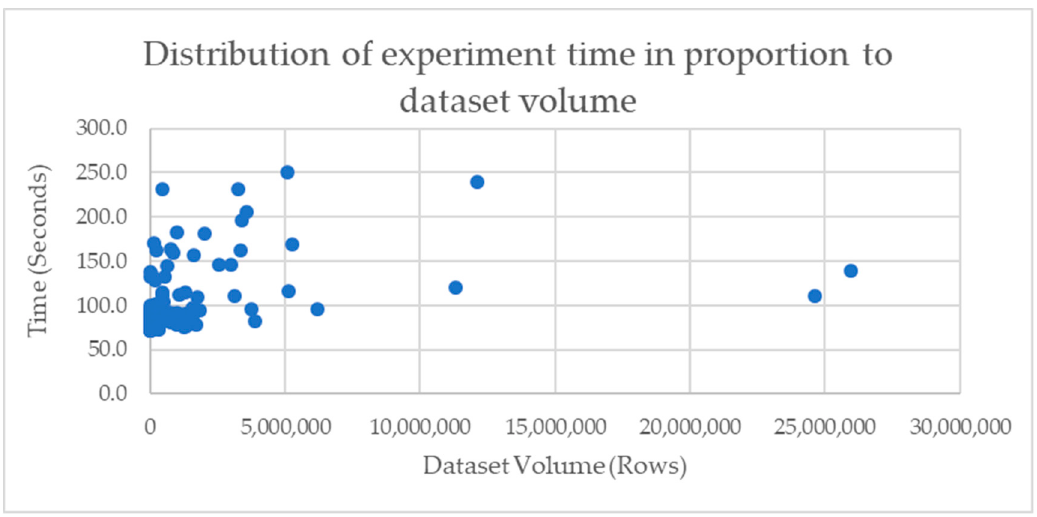
Figure 8. Scatterplot showing how experiments are distributed in proportion to the number of records each dataset contains.